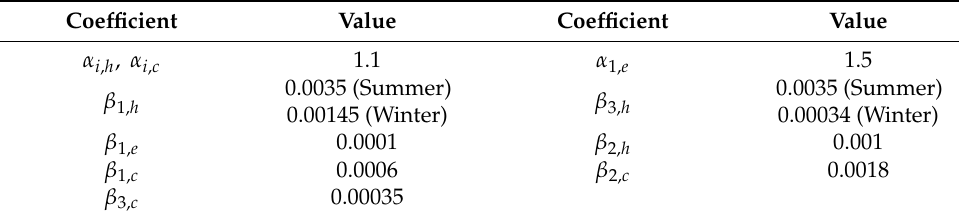
Figure A1. Load power curves of users. Table A1. The preference coefficient of users.